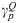
Chunk size, number of EM in each chunk, (left) as a function of the potentiation scaling factor in Q, γpQ, (right) as a function of the time constant in the synaptic dynamics, τ
z.The number of information-carrying items contained in the chunks depends on the system dynamics, suggesting that they have impact on the total capacity of the memory. The initial random conditions lead the system to different structures after learning (number and size of chunks). The case τ
z = 0 corresponds to completely removing the synaptic dynamics. Although the chunking is present in the absence of z
j, the characteristic time scale of z
j, τ
z has a powerful effect on chunk size. Each point was evaluated 100 times and the mean and standard deviation are presented, suggesting a monotonically increasing relationship between chunk size and γpQ or τ
z. In total, 98.6% of the runs exhibited sequential activity in the chunking layer. Total number of available chunk modes, N
Y = 30; total number of elementary modes, N
X = 30.